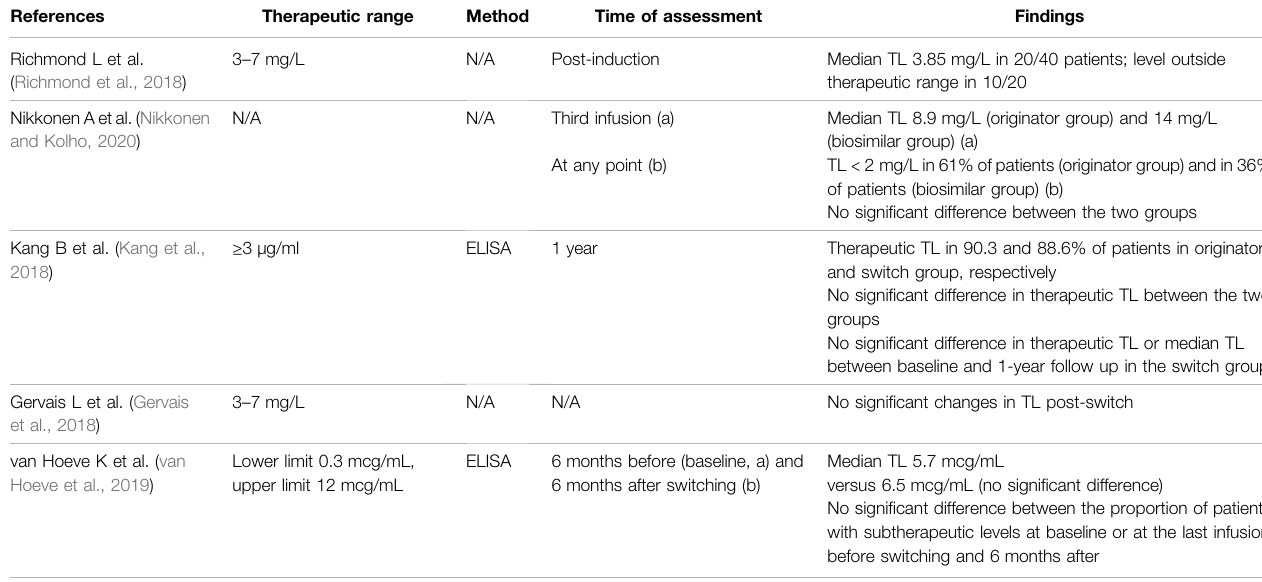
TABLE 2 | Studies investigating trough levels.